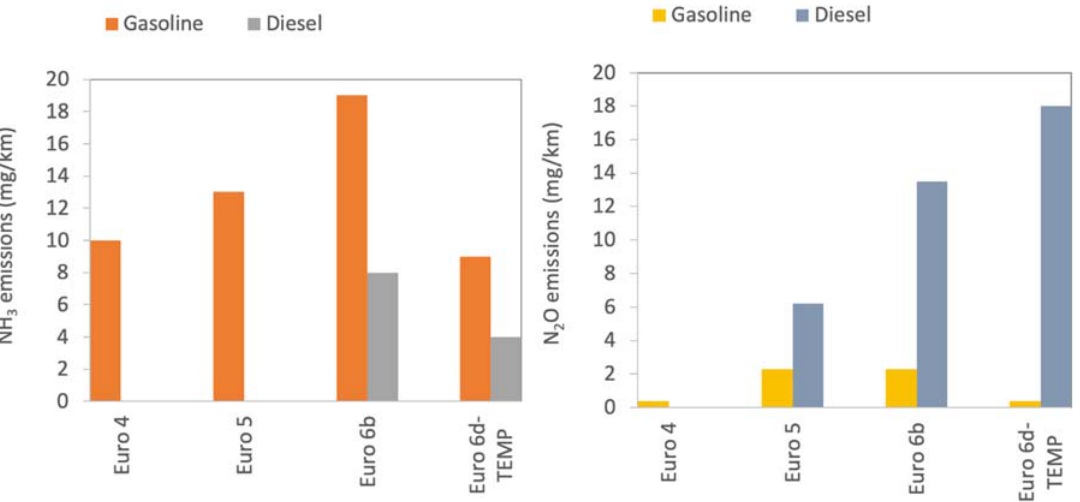
Figure 7. Emission factors of NH 3 ( left panel ) and N 2 O ( right panel ) from Diesel and gasoline light ‐ duty vehicles.